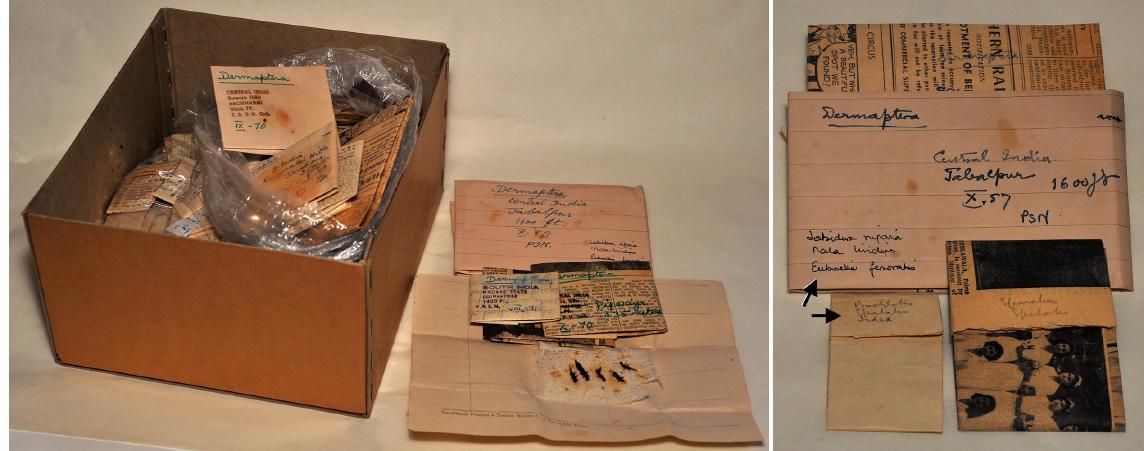
Fig. 4. Papered material from India collected by P.S. Nathan and T.R.S. Nathan between 1953 and 1972. Arrows indicate Brindle’s identifications (see comments in the text under ‘Alan